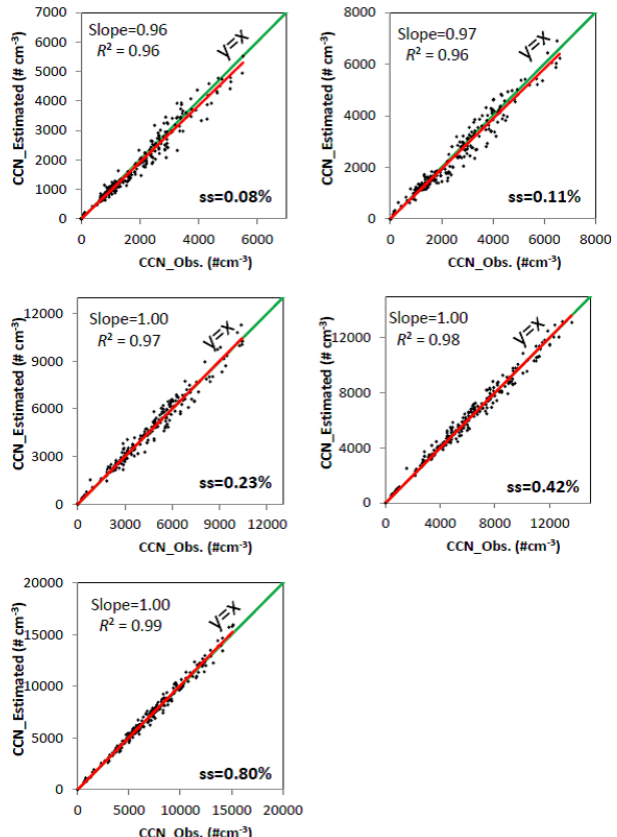
Figure 5. Estimated N CCN as a function of observed N CCN at dif- ferent SS levels in the parallel observation (PO) closure test. The green solid line is the 1:1 line.